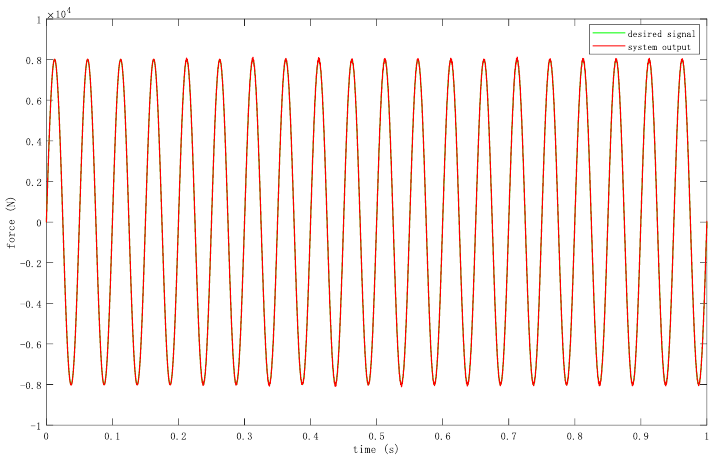
Figure 19. System loading output at 20 Hz frequency.